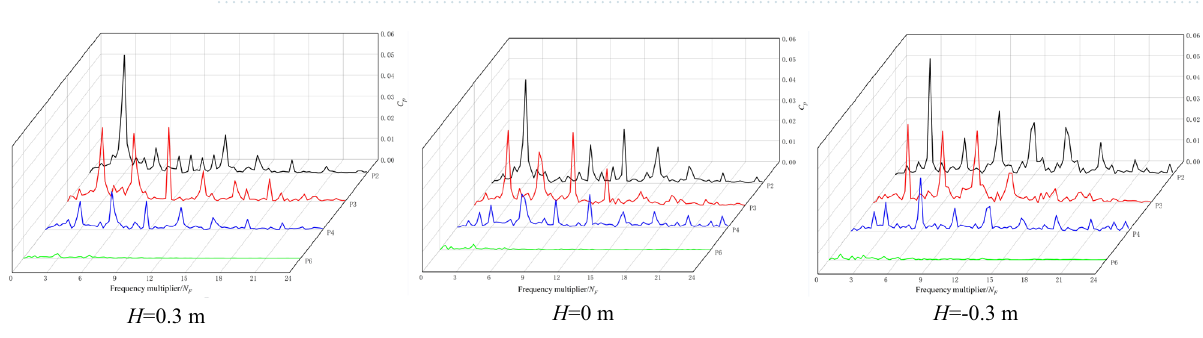
Figure 10. Frequency domain diagram of pressure fluctuation under the